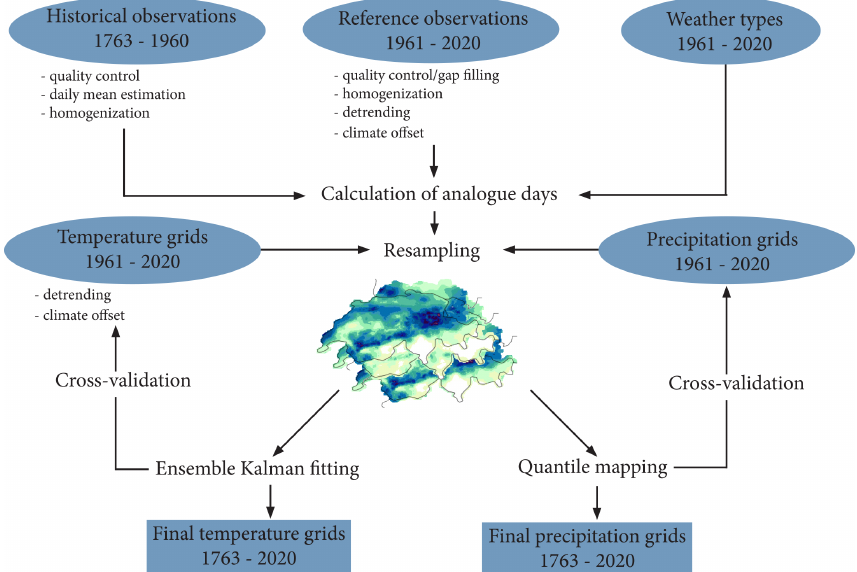
Figure 2. Schematic of temperature and precipitation reconstruction. Blue ellipses show input data. The necessary data preparation steps are listed below the input data. Blue rectangles show the final output data. Details on the individual steps are found in Sect.